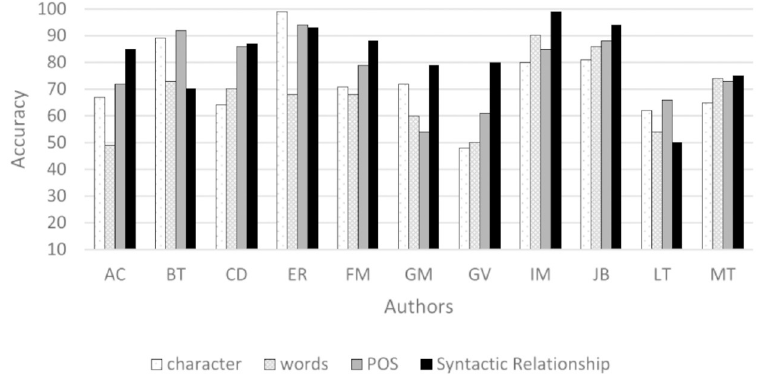
Fig 5. Average accuracy (%) of 3-grams using LSA